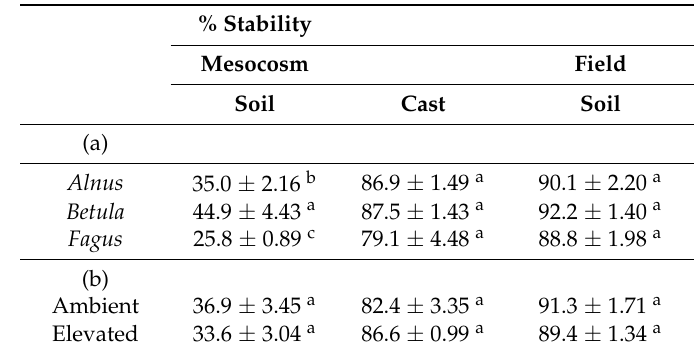
Table 7. Effect of ( a ) litter species and ( b ) CO 2 regime on % stable aggregates in soil and casts from mesocosm and field